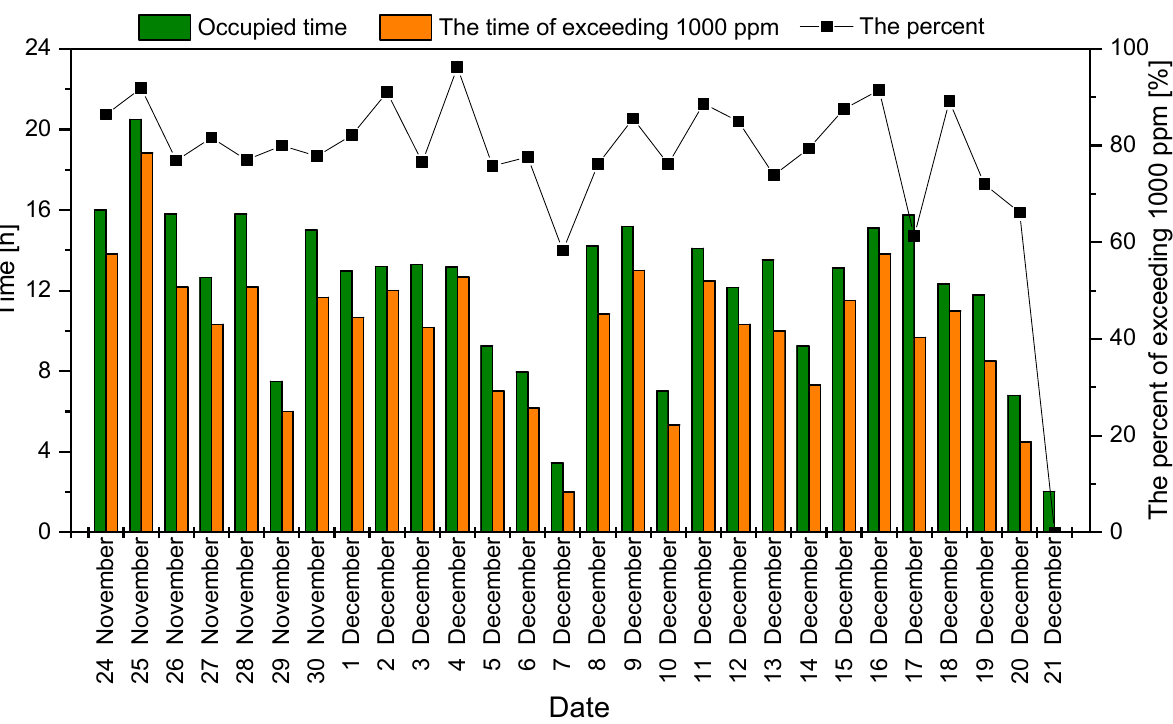
Figure 8. Summary of duration for indoor CO 2 level over 1000 ppm each day during monitoring period.